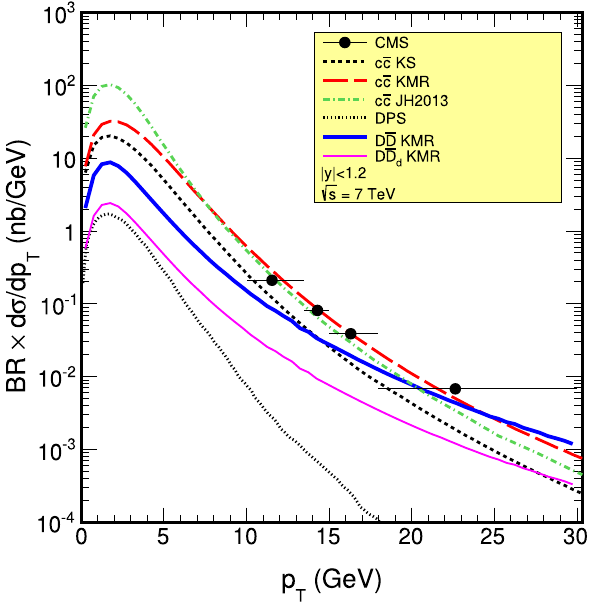
Fig. 3 Transverse momentum distribution of X ( 3872 ) for the CMS experiment. Shown are results for 3 different gluon uPDFs. Here BR = 0.038. The upper limit for the SPS molecular scenario is shown as the thick solid line. The thin solid line shows the molecular scenario neglecting the feeddown component of D 0 , ¯ D 0 . We also show corre- sponding distribution for the DPS mechanism (dotted line)